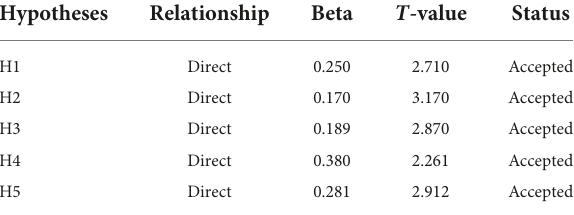
TABLE 4 Standardized path